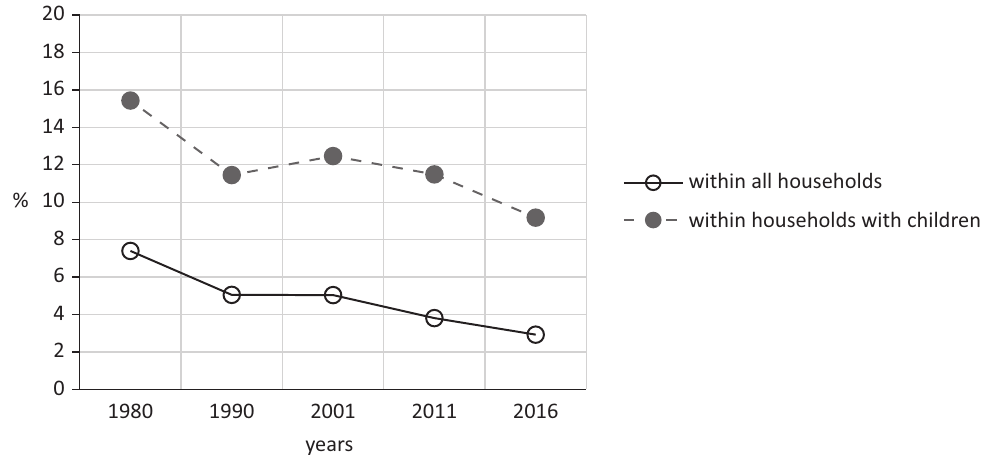
Figure 2. The ratio of TGHs within all households and households with children,